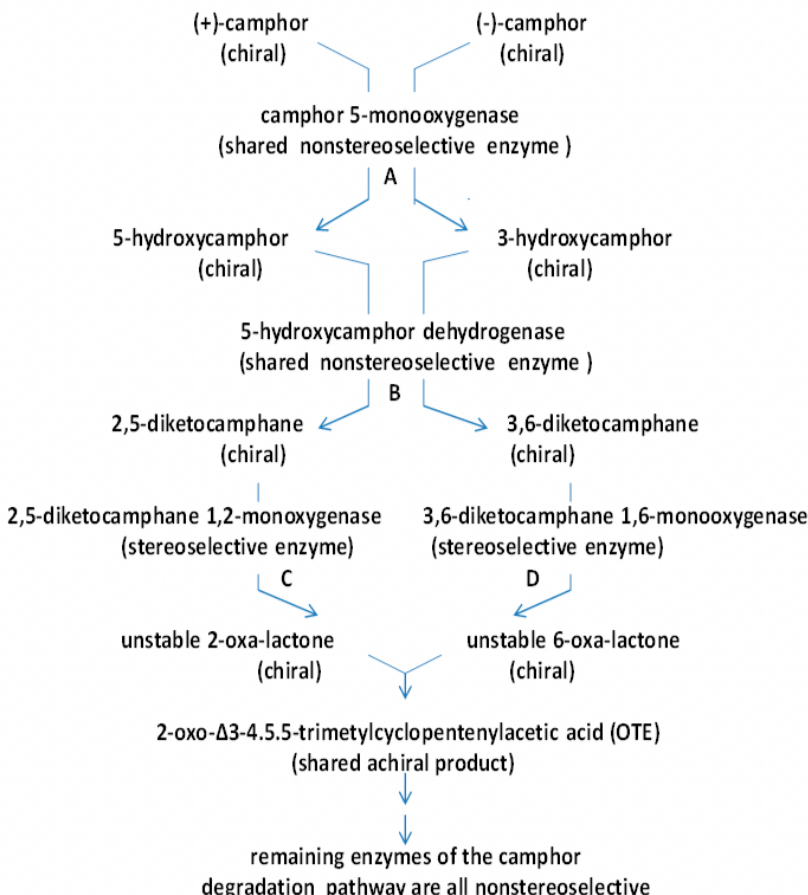
Figure 14. The relationships between nonselective and stereoselective enzymes that constitute the pathway for the degradation of ( rac )-camphor to OTE in P. putida ATCC 17453, and the roles of chiral and achiral molecules as substrates and transcriptional regulators. A = induction by (+)-camphor and ( − )-camphor, plus product induction by OTE: B = induction by (+)-camphor and ( − )-camphor, plus product induction by 2,5-DKC and 3,6-DKC: C = induction by (+)-camphor, ( − )-camphor and 2,5-DKC, plus cross-induction by 3,6-DKC, and product induction by OTE: D = ‘from the top’ coordinate induction by (+)-camphor, ( − )-camphor, and 3,6-DKC, plus cross-induction by 2,5-DKC, and product induction by OTE: A + B + C + D = ‘from the top’ coordinate induction by (+)-camphor and ( −